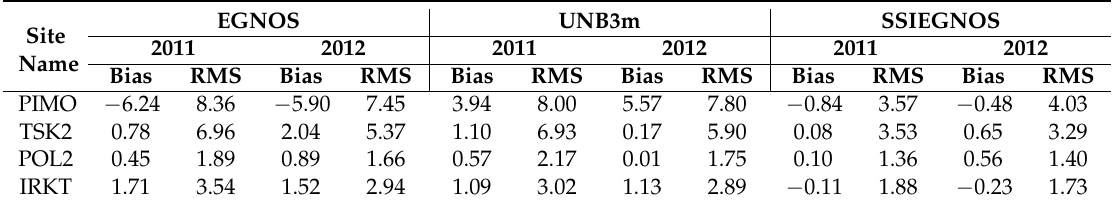
Table 3. Annual predicted bias and RMS error from 2011–2012 at the TSK2, POL2, IRKT, and TSK2 sites for the EGNOS, UNB3m, and SSIEGNOS models (Unit: cm). EGNOS Site Name